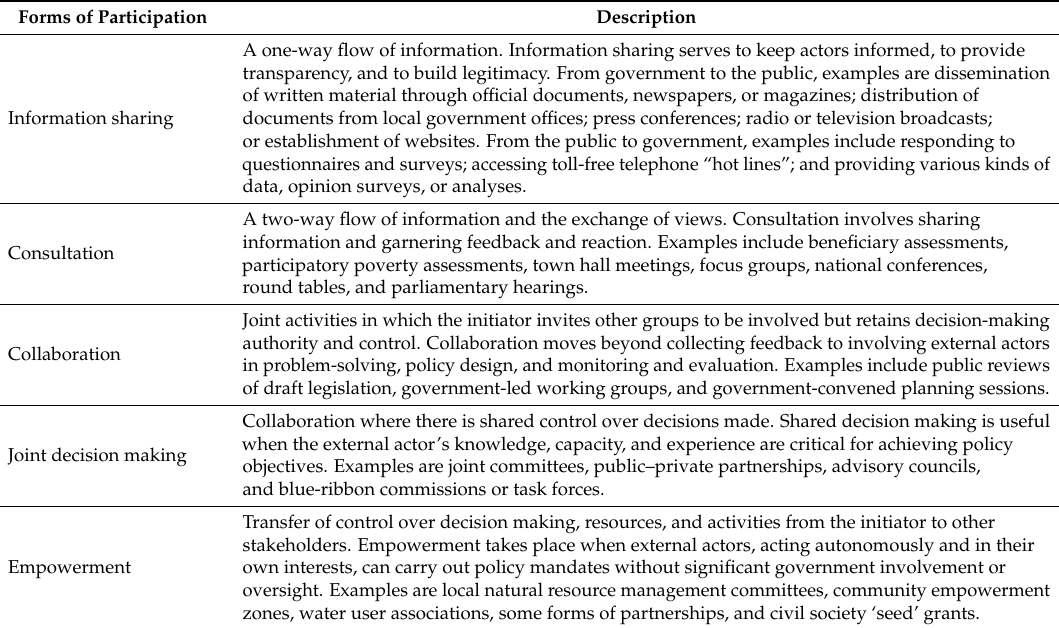
Table 4. Forms of stakeholder participation in the implementation of project